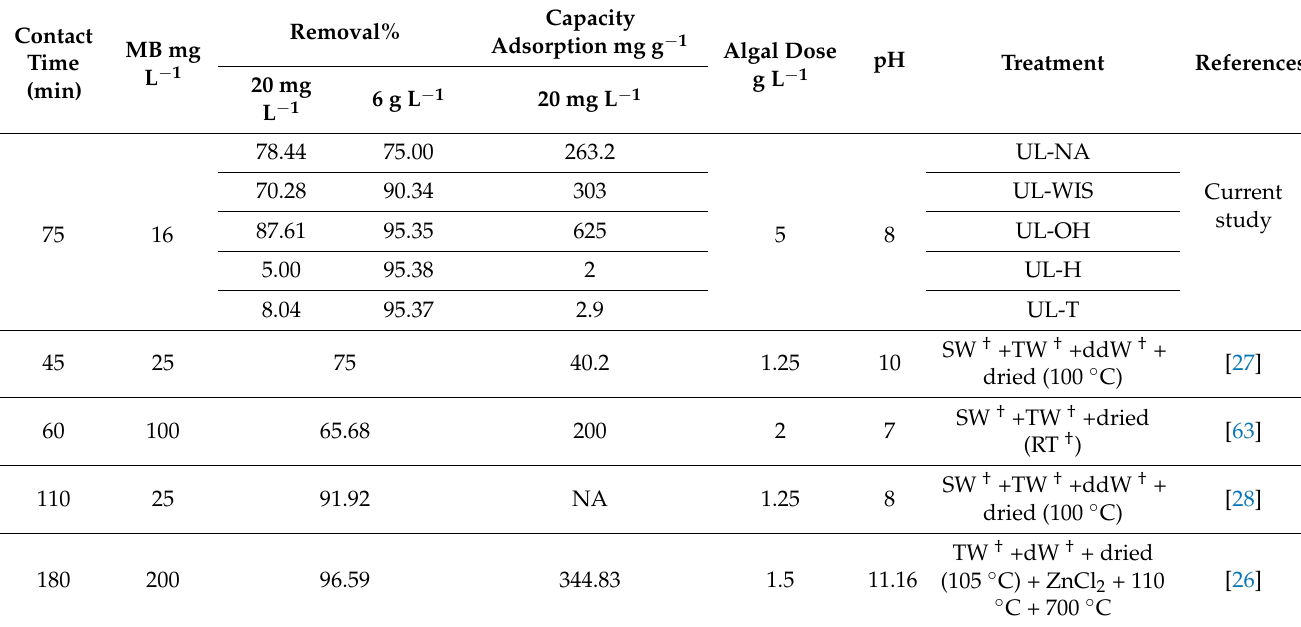
Table 4. Equilibrium time for biosorption of MB with U. lactuca